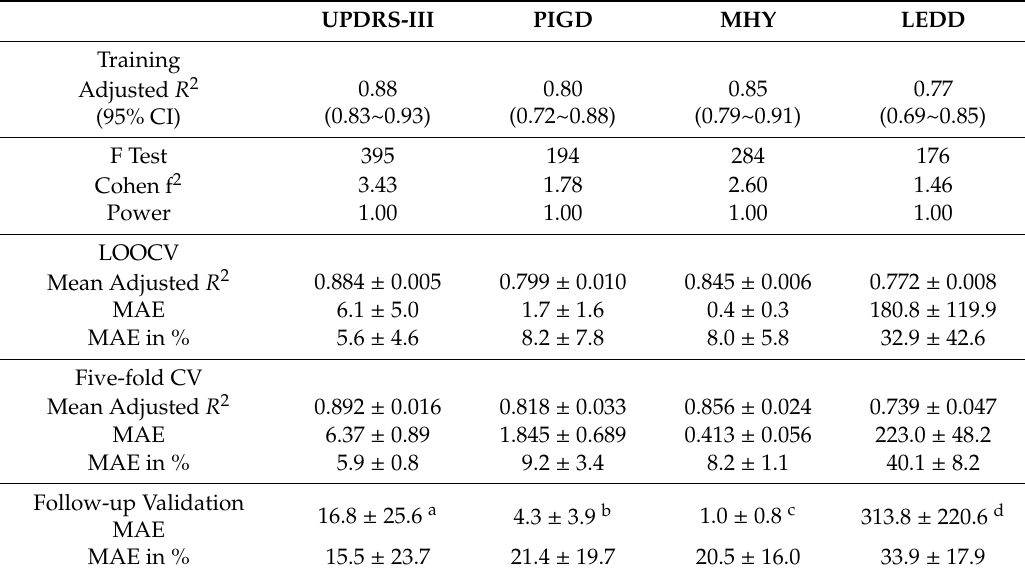
Table 3. Statistics of regression model for each